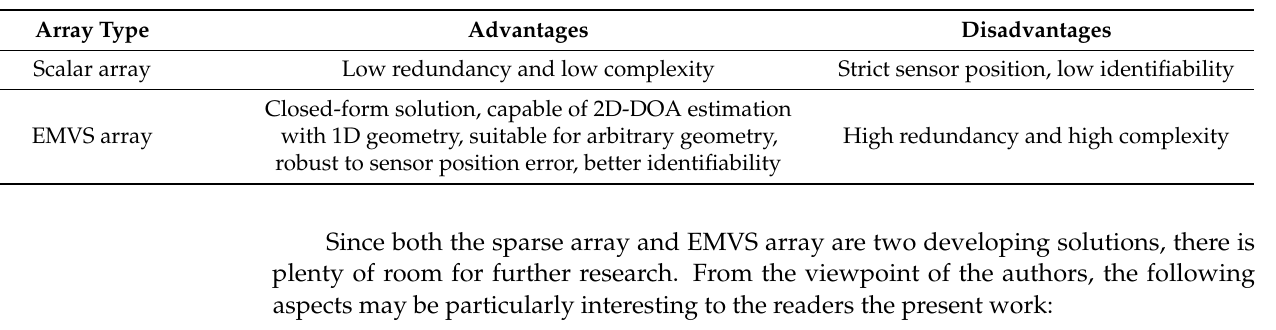
Figure 4. ( a ) Mutual coupling effect in DOA estimation with a ULA; ( b ) illustration of a coprime array; ( c ) EMVS array. Table 2. Advantages and disadvantages of sparse scalar/vector sensor